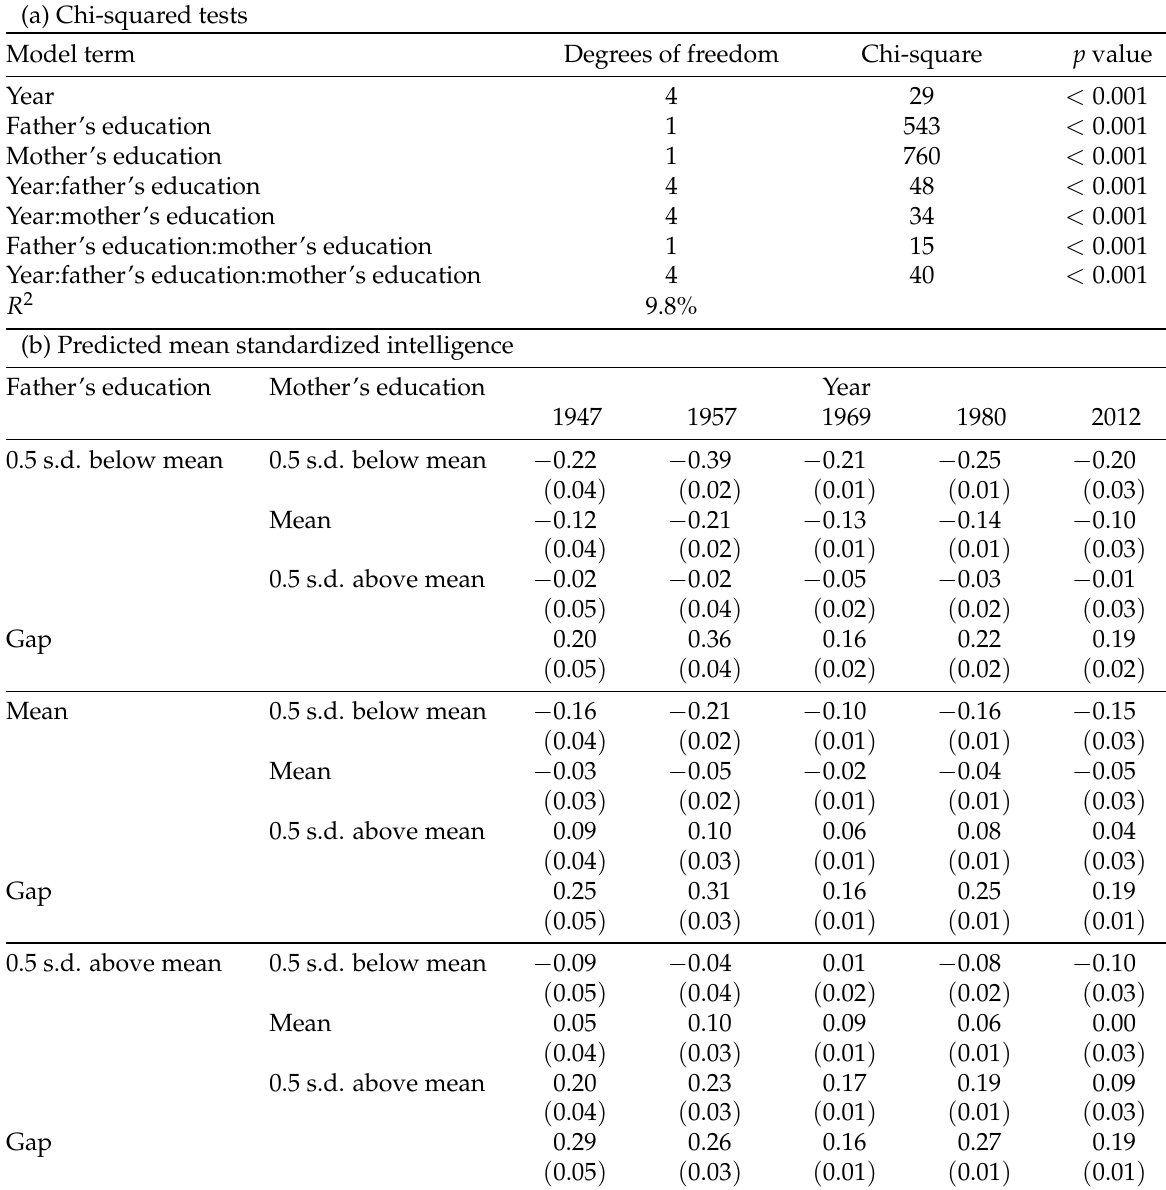
Table 3: Model of standardized intelligence in terms of year and parental